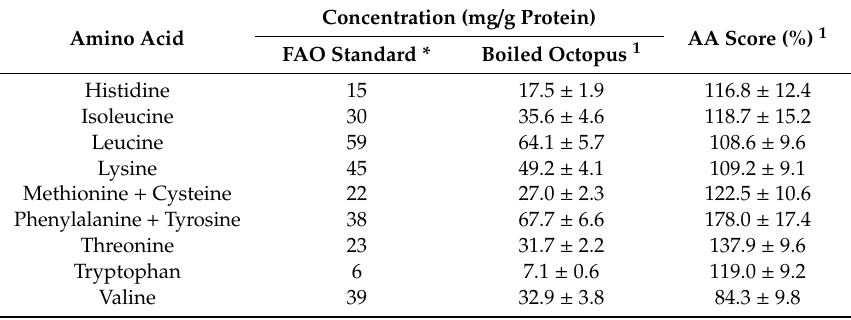
Table 7. Indispensable amino acid concentration and amino acid (AA) scores of boiled common octopus and Food and Agriculture Organization (FAO) reference standard concentration for